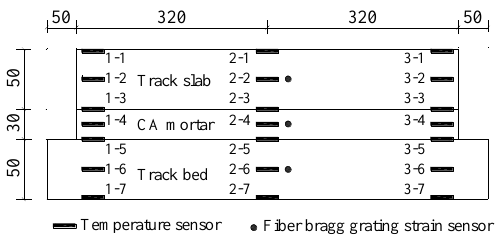
Figure 5. Schematic diagram of measurement point (mm).